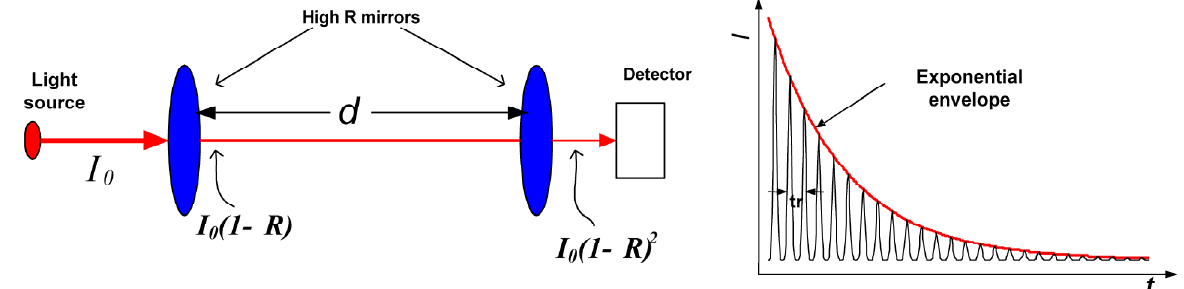
Figure 1. Illustration of the CRDS concept. The presence of additional absorption in the cavity is detected by a shortening of the decay time constant (ringdown time). In the CRDS, the effective absorption path-length is readily increased more than